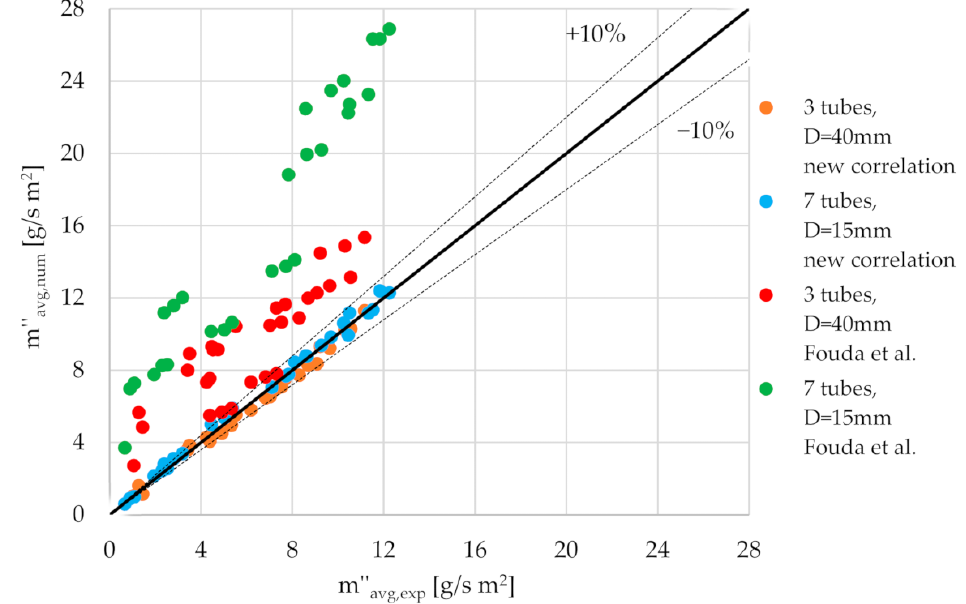
Figure 11. Comparison of the experimentally defined condensation mass fluxes compared with the theoretical results obtained from the modified correlation in Equation (11) and the theoretical results from the Fouda et al. correlation